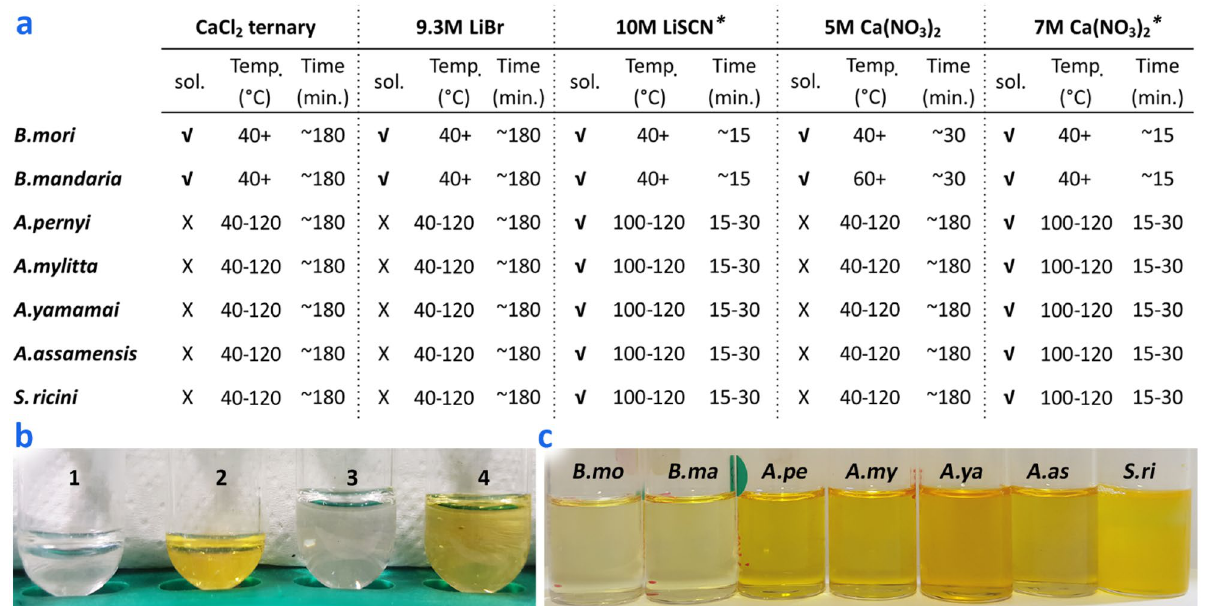
Figure 3. Comparison of the solubilisation capabilities of 5 different experimental salt solutions using modern silk samples derived from 7 different silk moth species. (a) Summary of the conditions required for solubilisation (sol.) (and whether achieved or not), including temperature (temp.) and time in minutes (min.) as determined but the disappearance into solution of the solid silk sample. *Wild silk samples showed no evidence of solubilisation at 40°, 60°, or 80 °C for ~ 180 min. (b) Xanthoproteic reaction of silk fibroin ( S. ricini ) solution by formic acid: 0.5 mg fibers in each tube with (1) 500 μl of 7 M Ca(NO 3 ) 2 , (2) 500 μl 7 M Ca(NO 3 ) 2 + 0.1% FA on the weight of fabric, (3) 1 ml 7 M Ca(NO 3 ) 2 , and (4) 1 ml 7 M Ca(NO 3 ) 2 + 0.1% FA. Formic acid was added after solubilisation occurred in the salt solution at 130 °C for 10 min. (c) 7 M Ca(NO 3 ) 2 fibroin solutions of